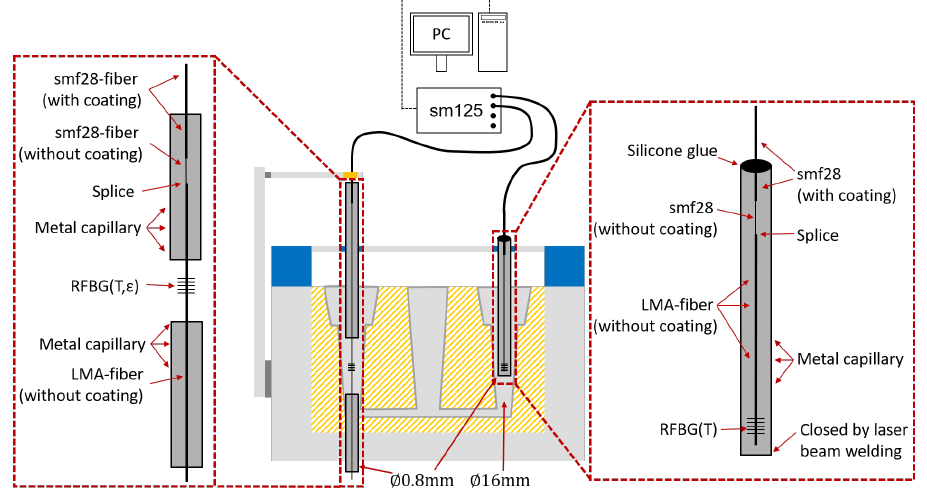
Figure 10. Setup for the casting process with an RFBG strain sensor (RFBG(T, ε )) and an RFBG temperature sensor RFBG(T).